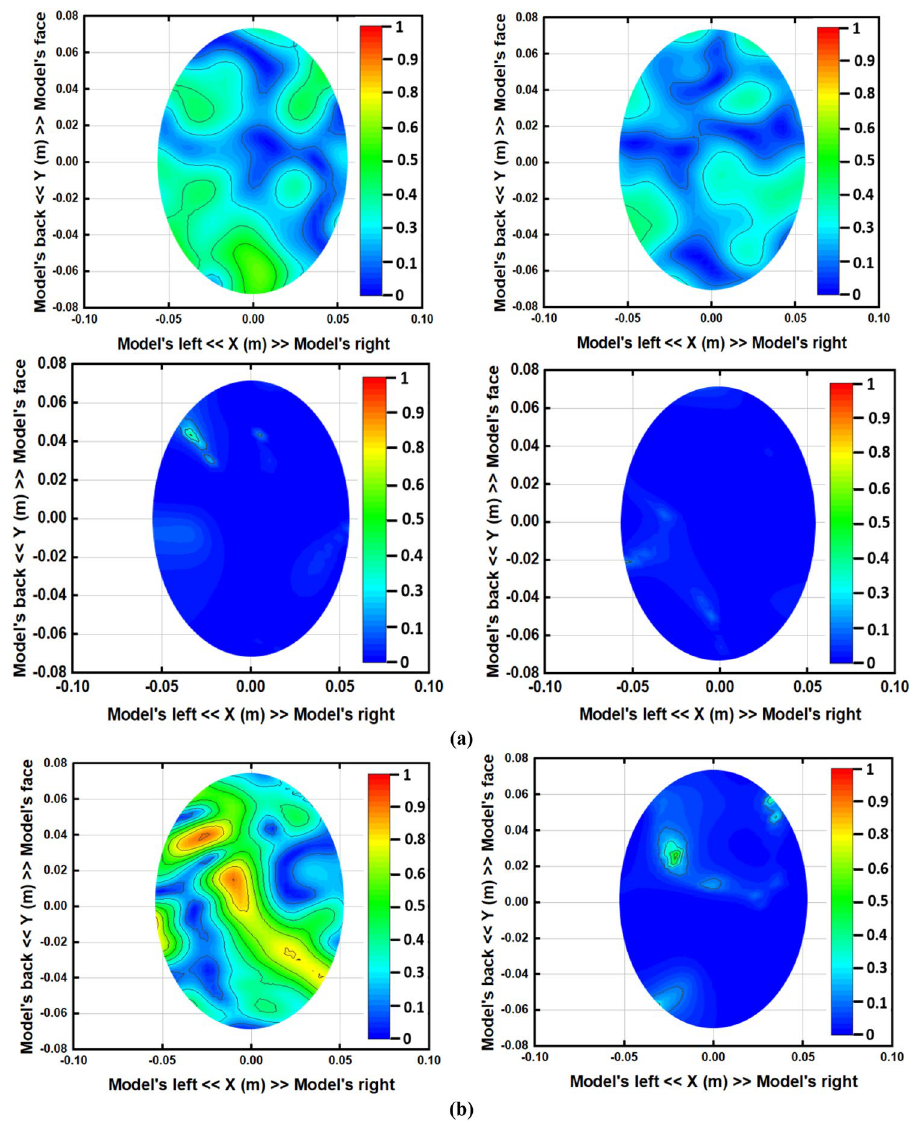
Figure 10. Reconstructed images using the antenna on different positions (with DMAS and IC-CF-DMAS) ( a ) blank data ( b ) human head model without stroke ( c ) human head model with